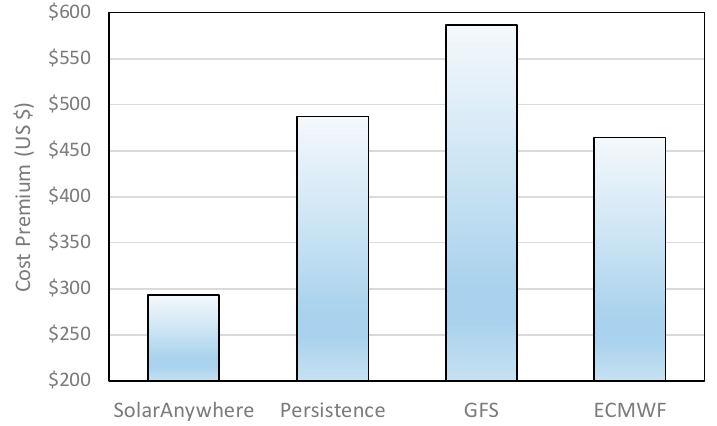
Figure 5. Comparing firm forecast cost premium per nominal KW as a function of the forecast model. Displayed costs represent a mean for all scenarios and time horizons analyzed.